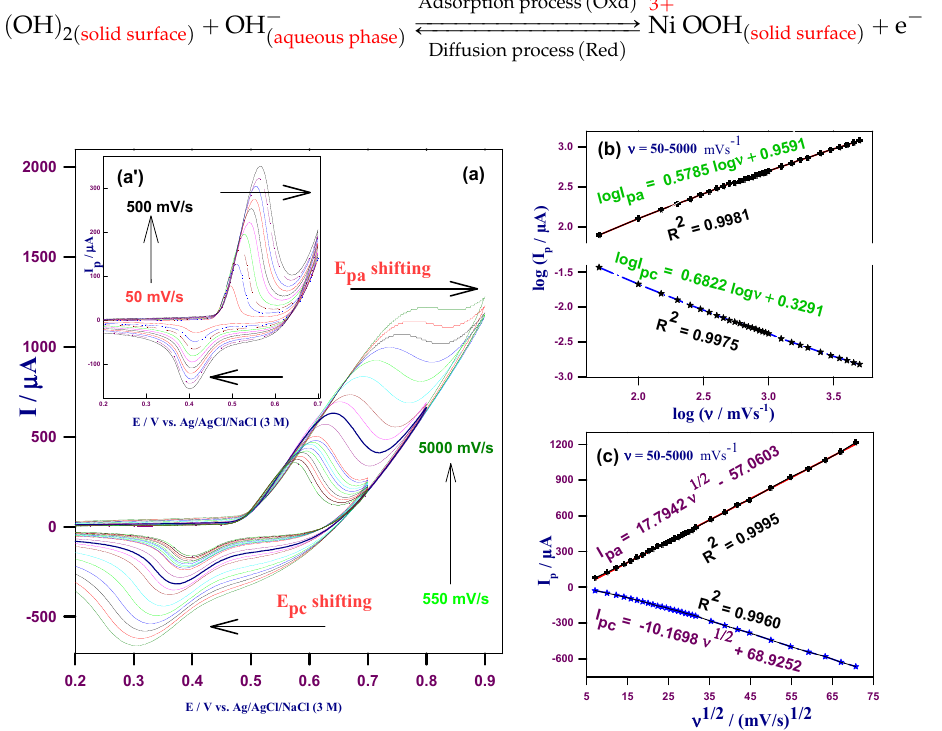
Figure 2. CVs of the conditioned HCNiO/GC electrode in 0.05 M NaOH at different scan rates of inset ( a’ ) 0.05, 0.1, 0.15, 0.2, 0.25, 0.3, 0.35, 0.4, 0.45, 0.5 V·s − 1 and ( a ) 0.55, 0.6, 0.65, 0.7, 0.75, 0.8, 0.85, 0.9, 0.95, 1, 1.25, 1.5, 1.75, 2, 2.5, 3, 3.5, 4, 4.5, and 5 V·s − 1 (current response from lower to higher, respectively); ( b ) Plot of log I p vs. log ν ; and ( c ) Plot of I p vs. ν 1/2